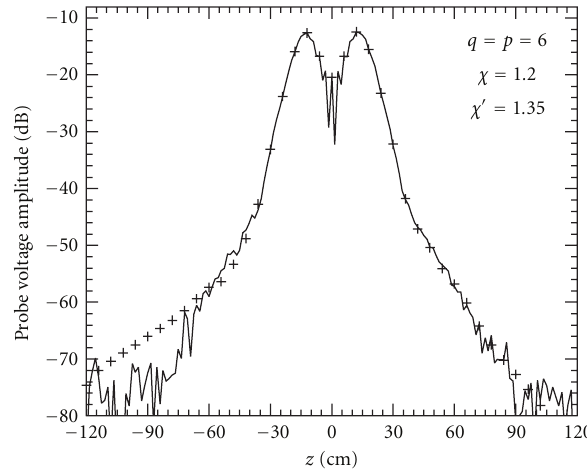
Figure 18: Amplitude of the probe output voltage V on the generatrix at ϕ = 0 ◦ . Solid line: measured. Crosses: